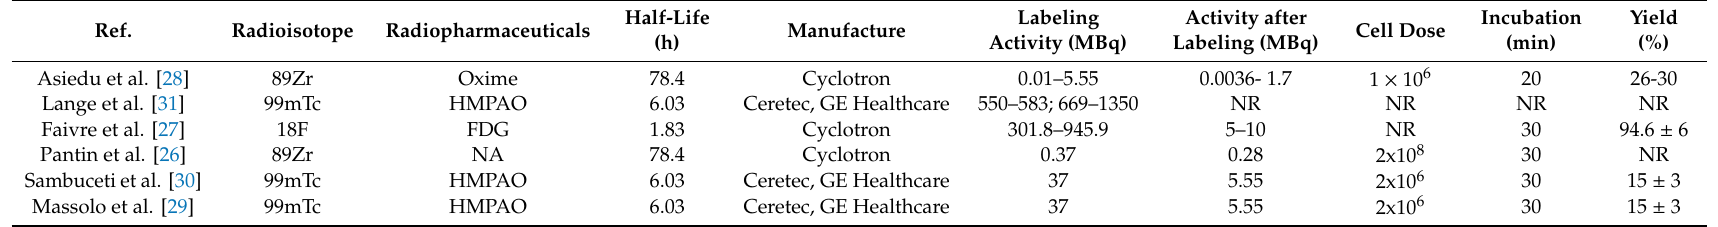
Table 3. Labeling of hematopoietic stem cells with radioisotopes /